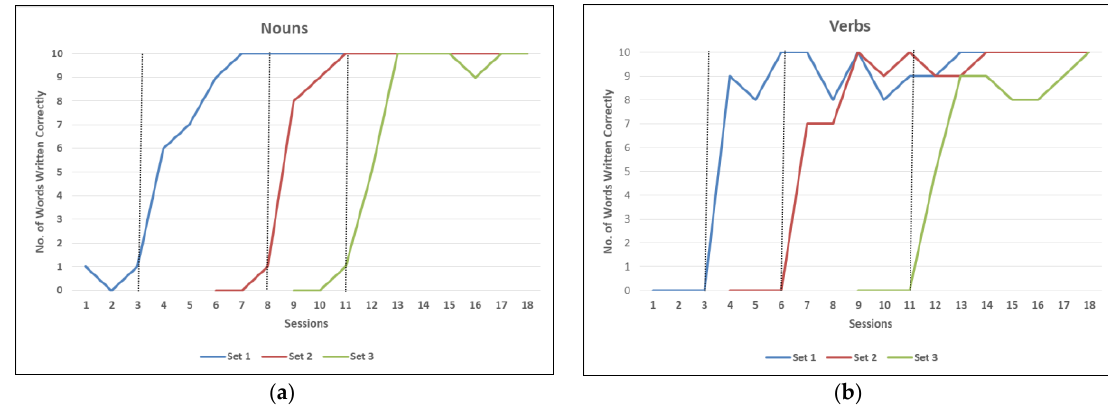
Figure 4. ( a , b ) Pre- and post-treatment on nouns ( a ) and verbs ( b ) over 18 sessions in English. The dashed lines show the baseline score for each set before the treatment begins.